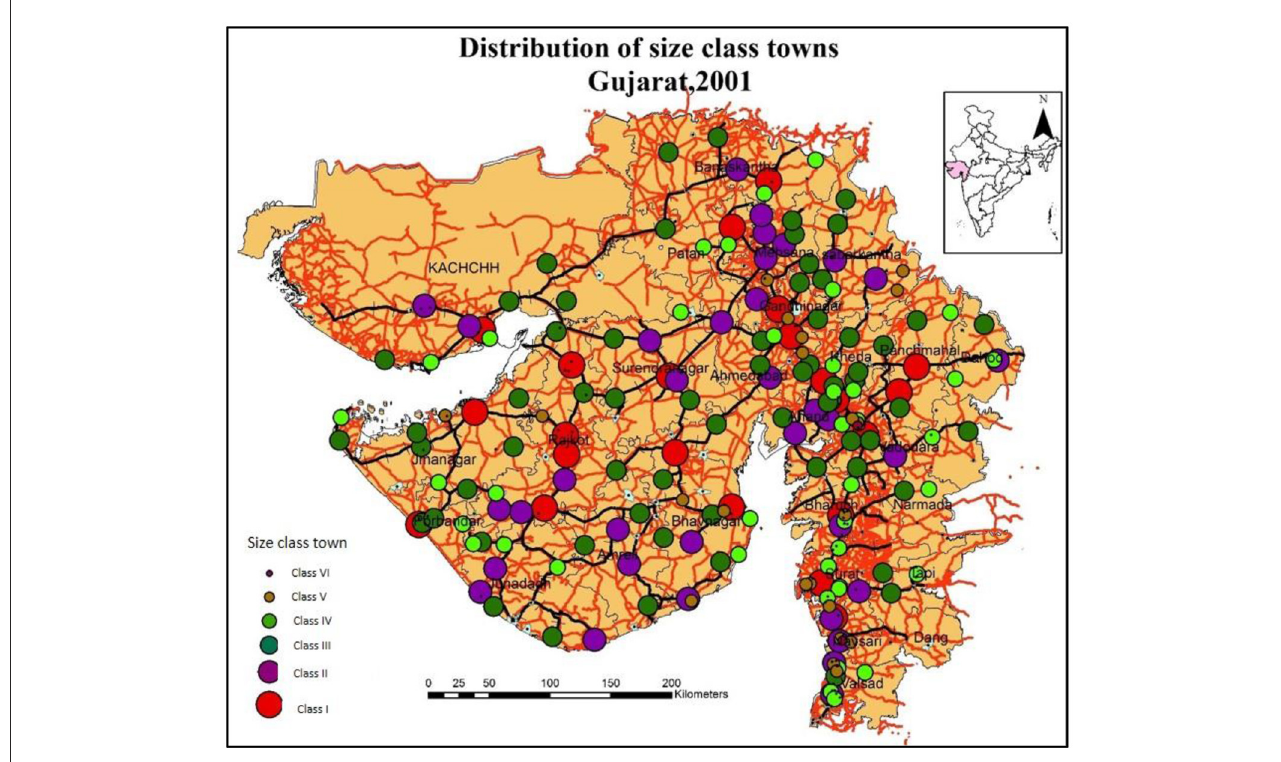
FIGURE4 Distribution of size class towns in Gujarat-2001. Source: Prepared by the Authors,